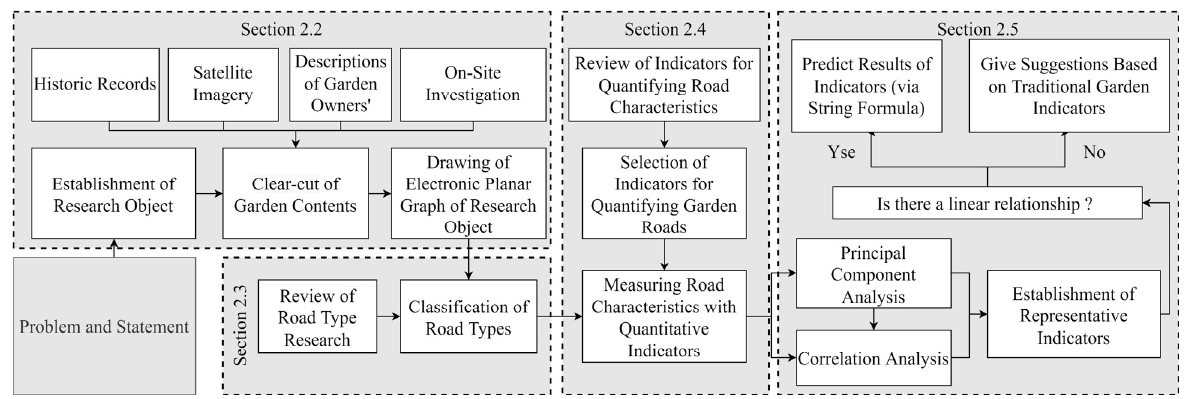
Figure 1. Research